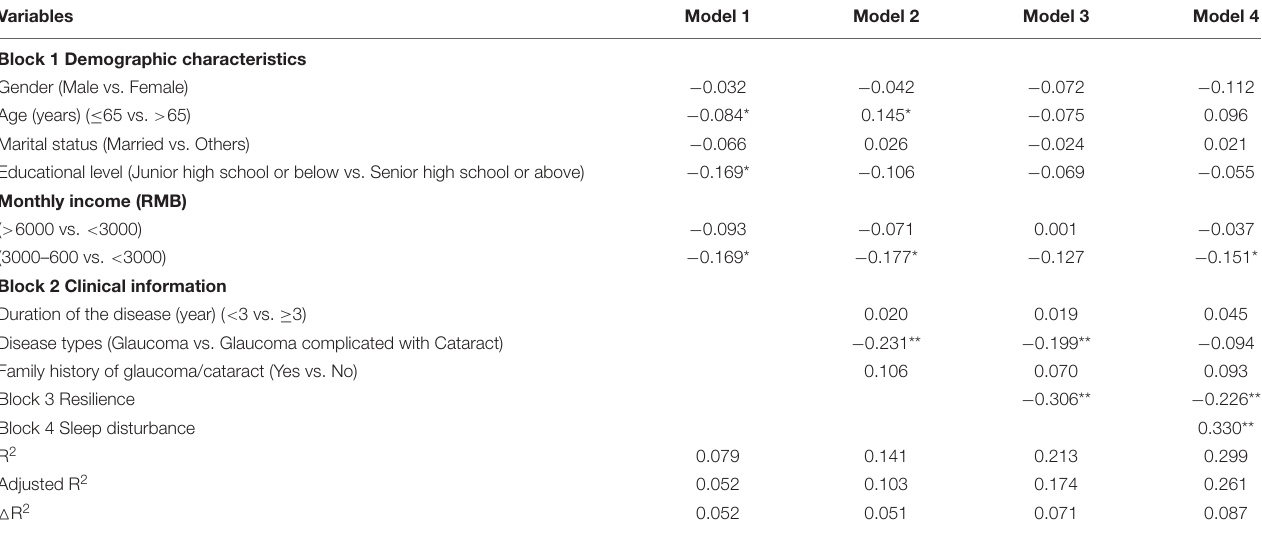
FIGURE 1 | Forest graph of the hierarchical multiple regression analysis of QoL. TABLE 3 | The hierarchical multiple regression analysis of QoL ( N = 215).